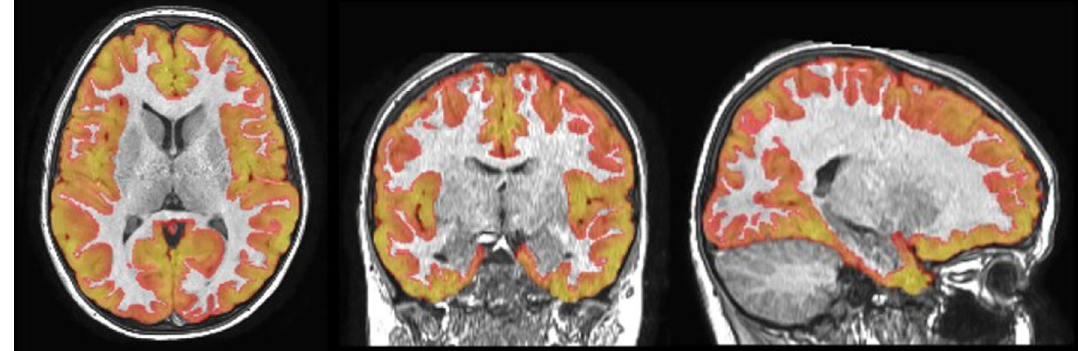
Fig. 6 Selected axial, coronal and sagittal images showing color‑coded segmentation of cortical grey matter during cortical thickness